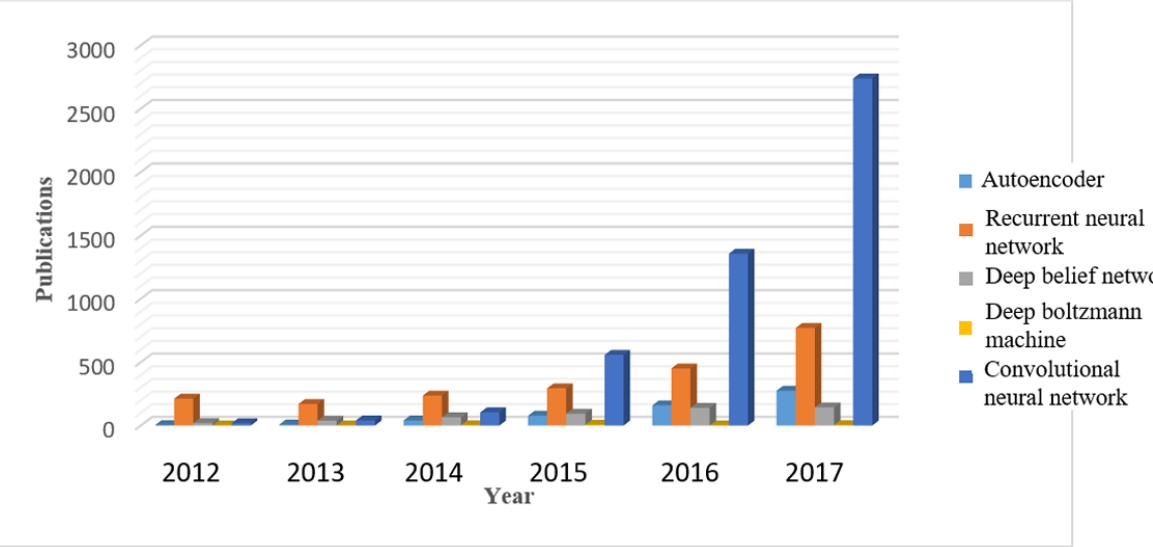
Figure 13. Publications distributions for 5 years in different categories of deep learning methods. These figures are extracted from the Institute of Electrical and Electronics Engineers database of papers from conferences and journals and magazines by using advanced query to search in publication title and abstract containing any of the deep learning methods ((“Publication Title”: Autoencoder) OR (“Abstract”: